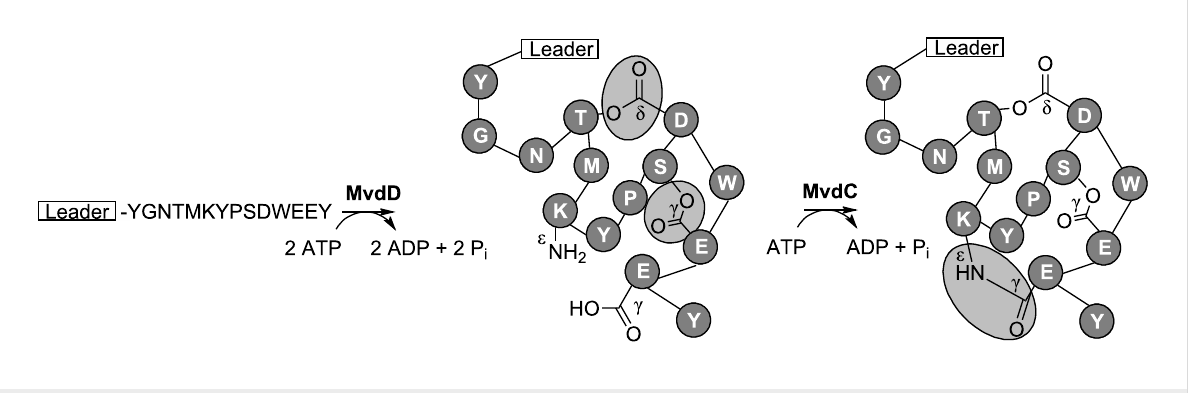
two ω -ester linkages between threonine and aspartate and serine and glutamate (MdnC/MvdD) and one ω -amide linkage between lysine and aspartate (MdnB/MvdC) (Figure 10) [64,65]. Microviridins can be heterologously produced in E. coli [65]. Cyclizations occur in a strictly defined order.